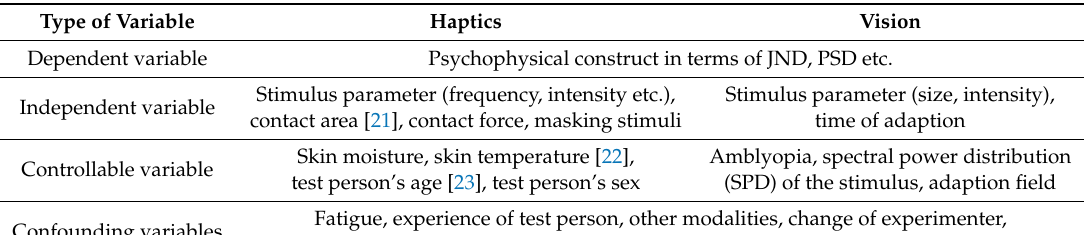
Table 1. Examples for possible variables in haptic and visual